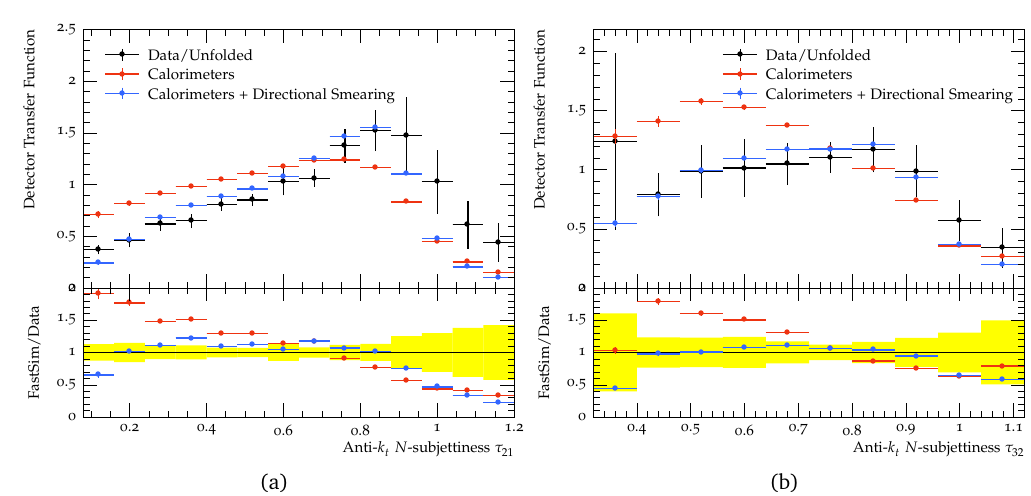
Figure 6: The detector transfer function extracted from data by dividing the detector- level distributions by the unfolded distributions, and two fast detector simulations with and without directional smearing for the R = 1.0 anti- k τ , τ as measured in a 7 TeV inclusive dijet sample with p 21 32 Ref. [ 36 ]